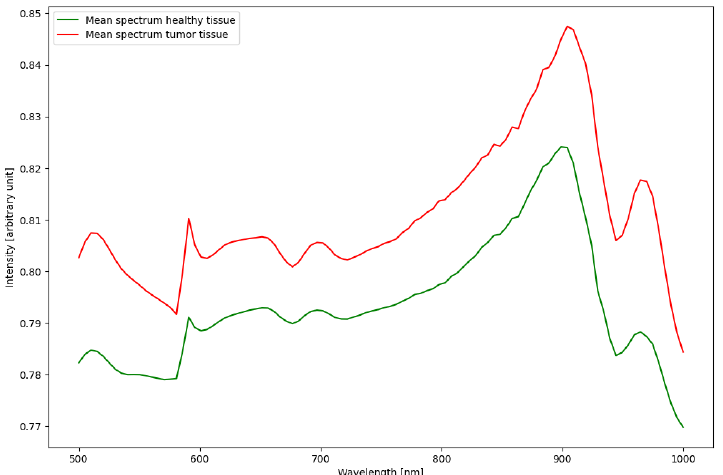
Figure 1. The average spectrum for all pixels labelled either healthy or tumor. A detailed view of each spectrum, including the standard deviation, can be found in the supplements in Figure